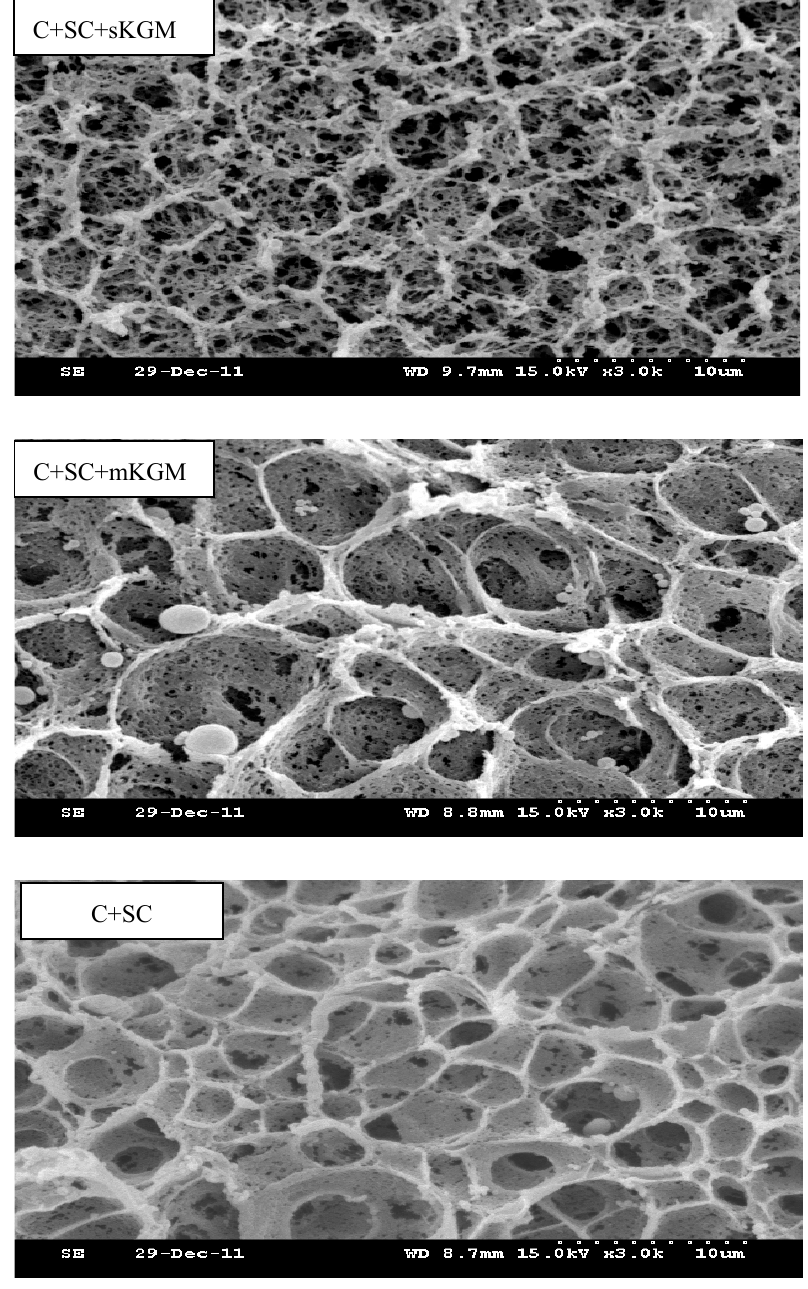
Figure 6. SEM micrographs (3000×) of 200 MPa LP+H rabbit myosin protein gels.